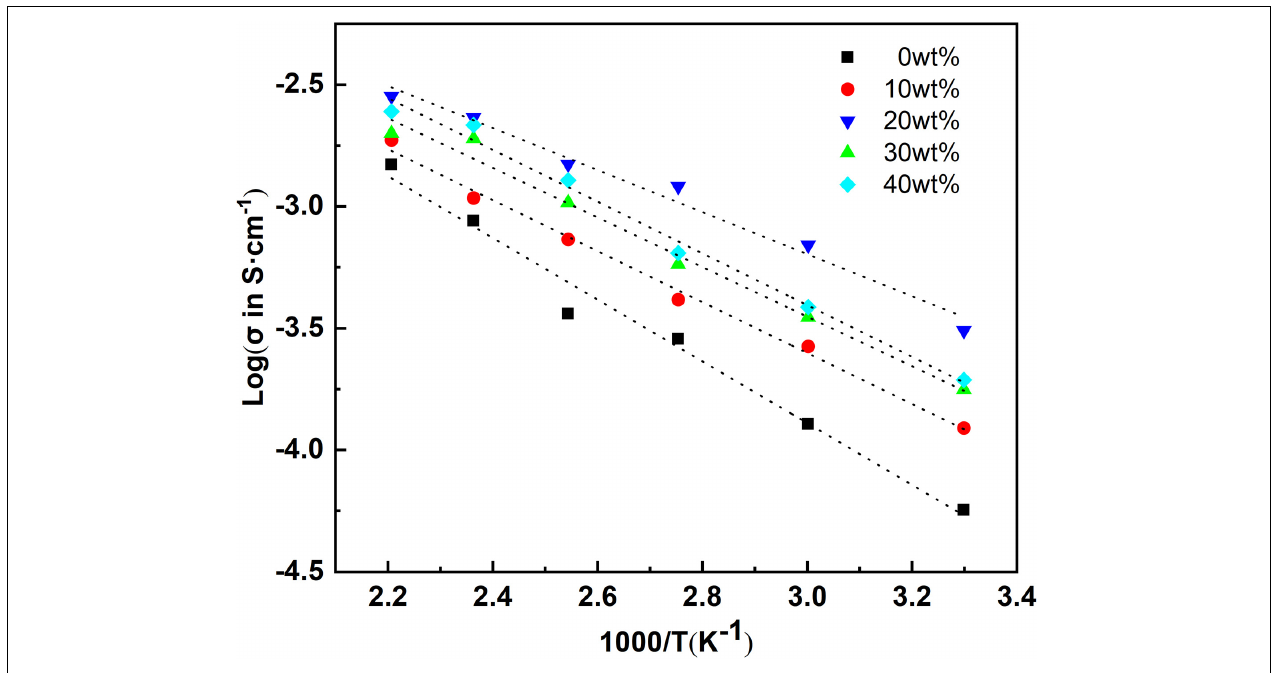
FIGURE 4 | Arrhenius plots of the LTPO samples in the temperature range of 303–453 K.